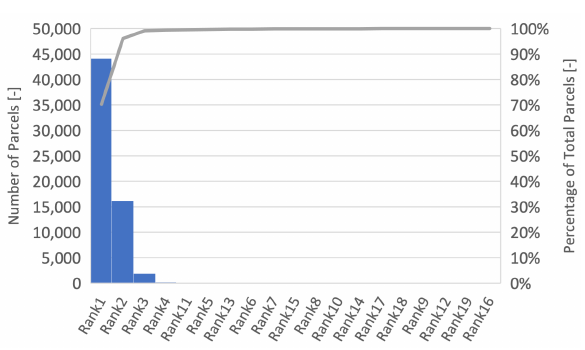
Figure 7. The number of parcels per rank. For each parcel, the acquisition date was selected based on the data quality (absence of cloud and shadows) and NDVI <